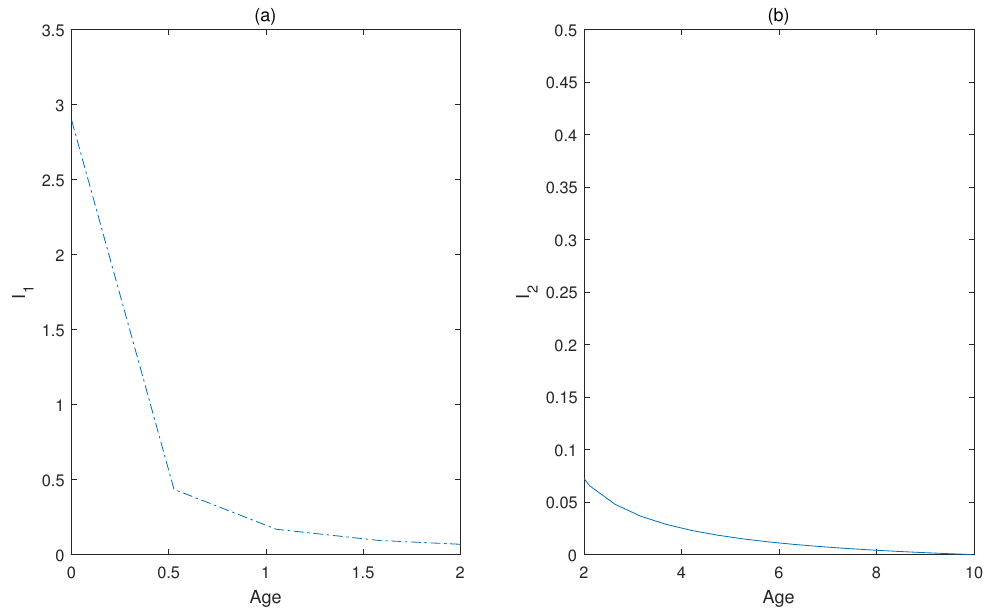
Figure 4. ( a ) Age distributions of infected individuals at the acute stage. ( b ) Age distributions of infected individuals at the chronic